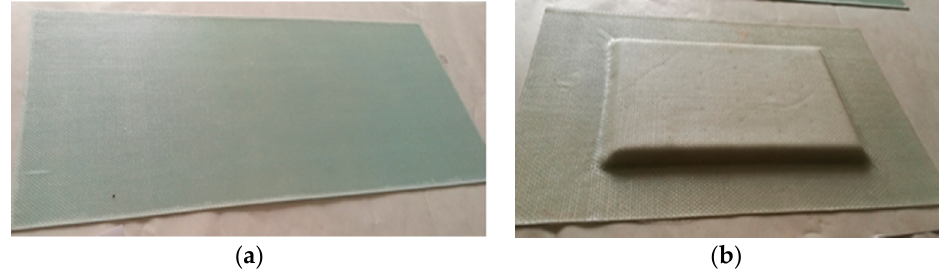
Figure 1. Example of composite material without core ( a ) and with core ( b ).